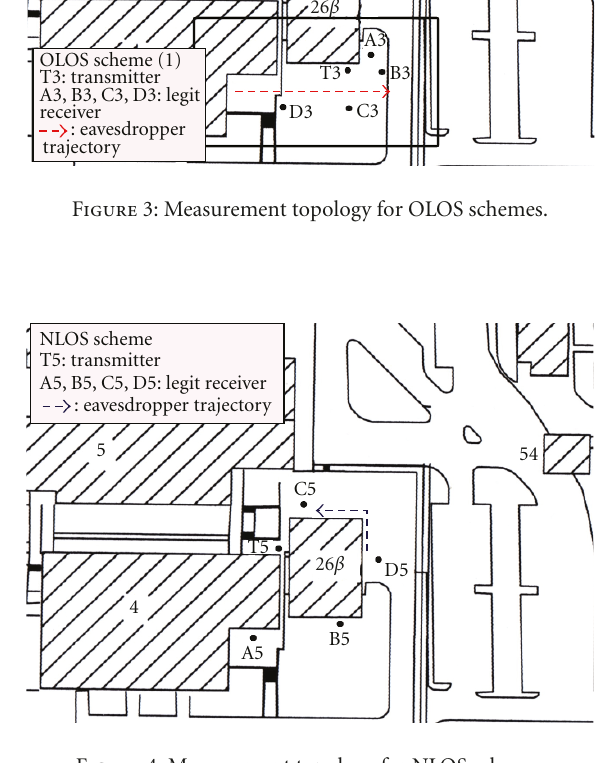
Figure 4: Measurement topology for NLOS scheme.